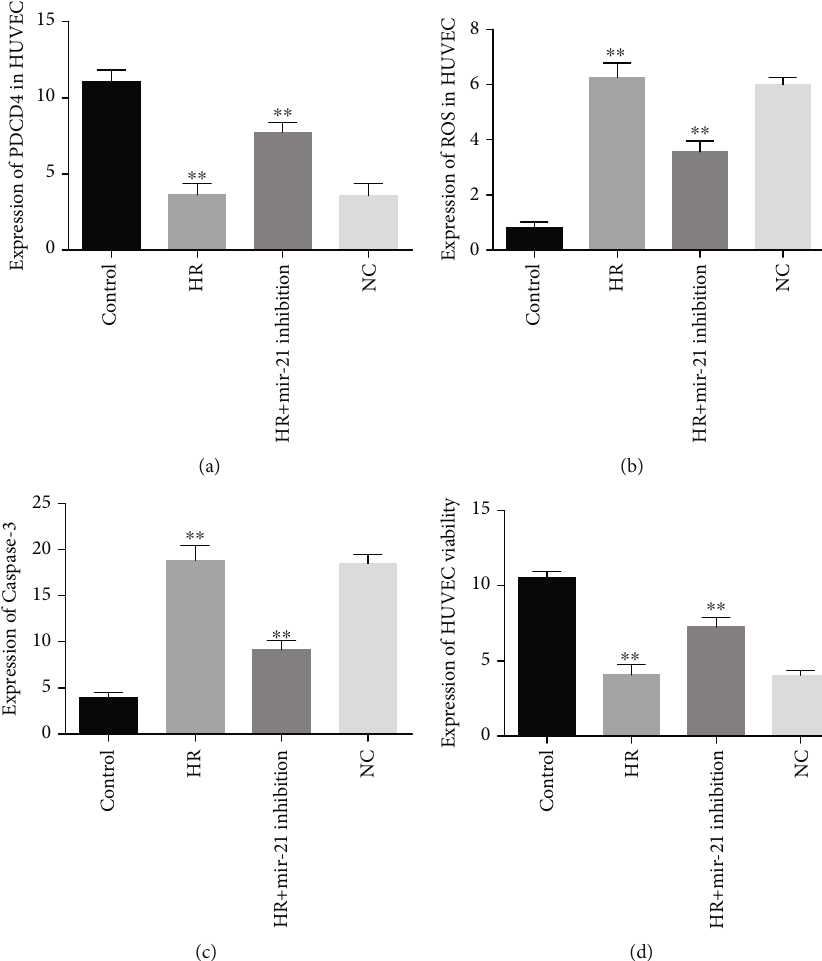
Figure 4: E ff ects of mir-21 inhibition on HUVECs: (a) the relative expression levels of PDCD4 in normoxic and HR cells; (b) intracellular ROS generations in normal HUVEC versus HR-injured cells; (c) caspase-3 expression between normal culture and HR-incubated cells; (d) cellular viability in HR and normal, HR and HR transfected with mir-21 inhibition, and HR and NC groups in HUVECs. ∗∗ P < 0 : 001